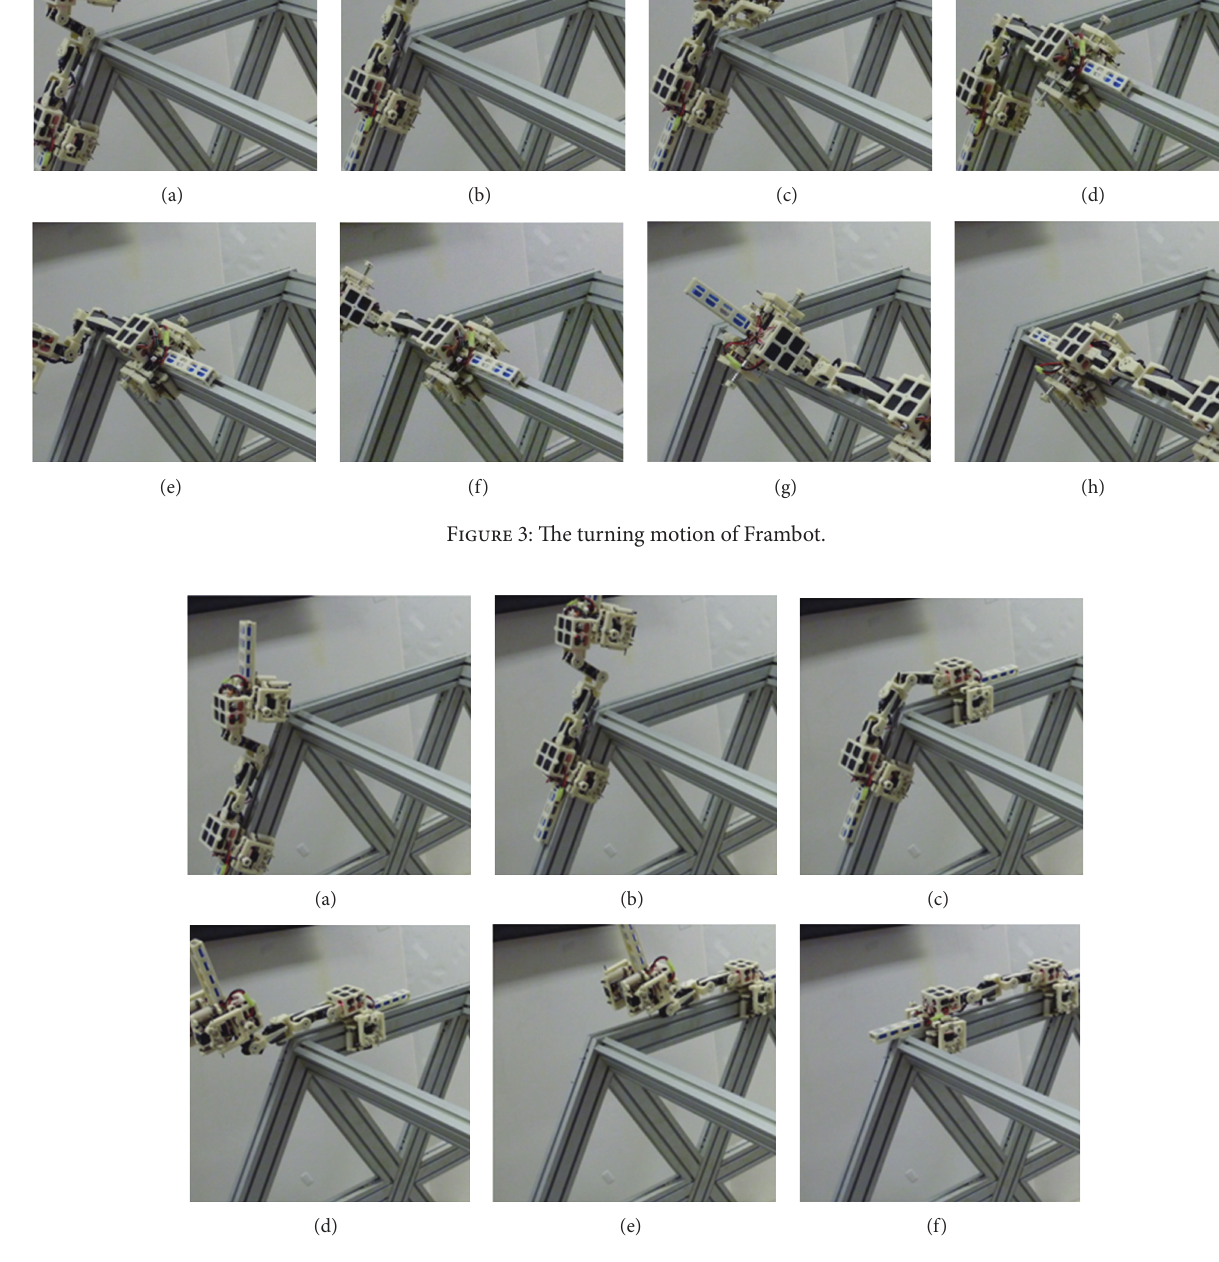
Figure 4: The exterior transition of